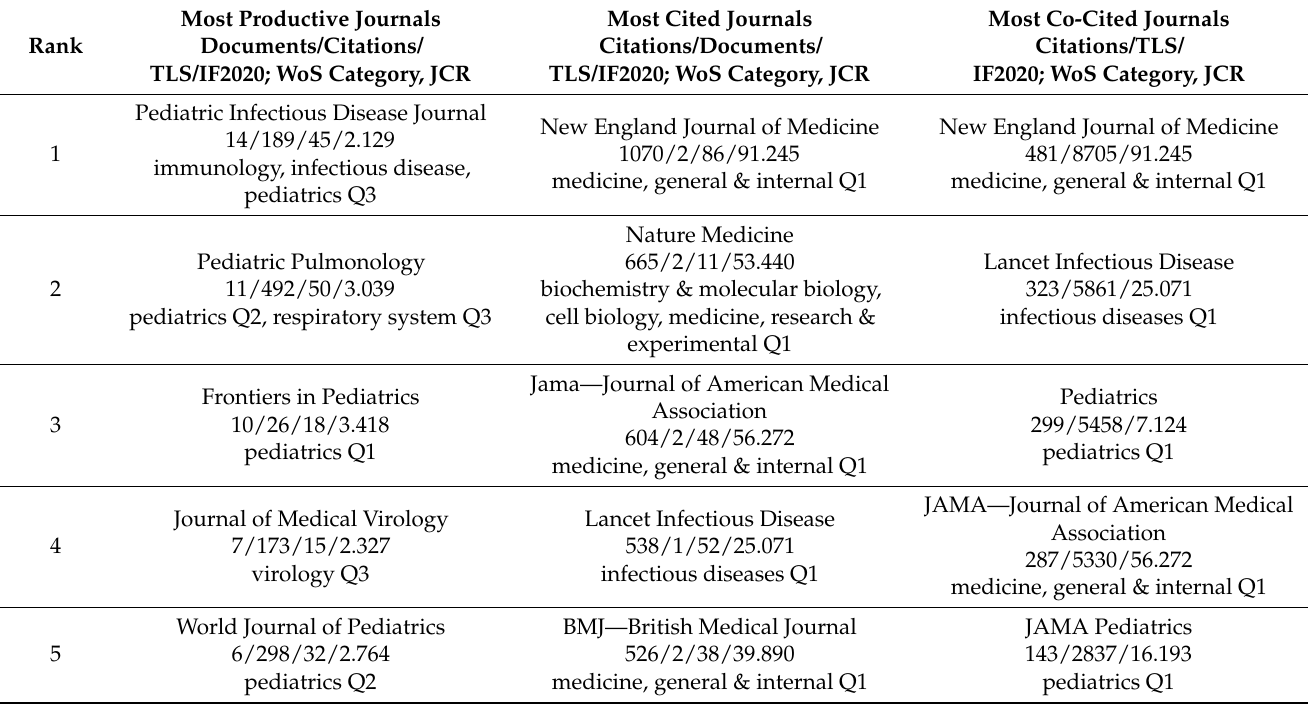
Table 2. Top productive and cited journals, most co-cited sources.